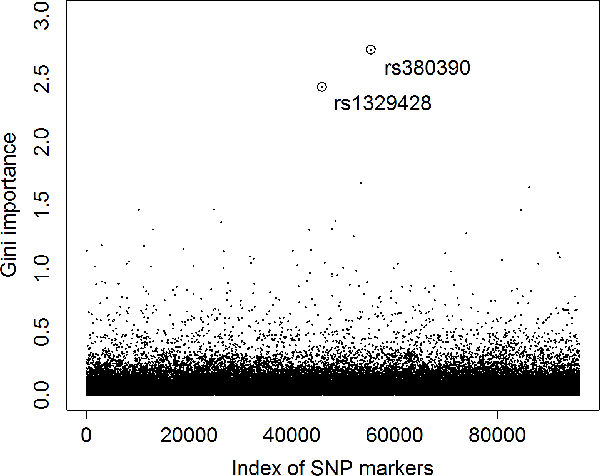
Gini importance of the SNPs in the AMD dataset. x-axis is the index of SNP markers. y-axis is the gini importance. The two circles represent the two SNPs that are already identified in literature [25].